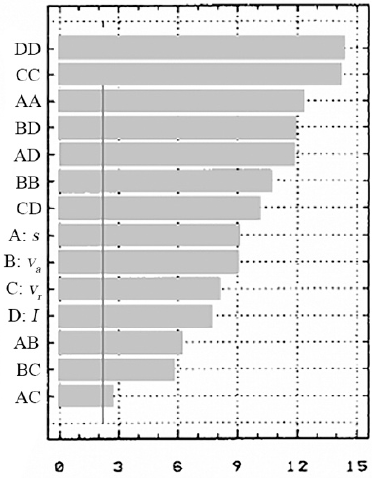
Figure 15. The input factors influence on R a [µm].